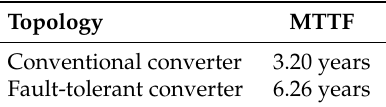
Table 4. Mean time to failure (MTTF) of the considered